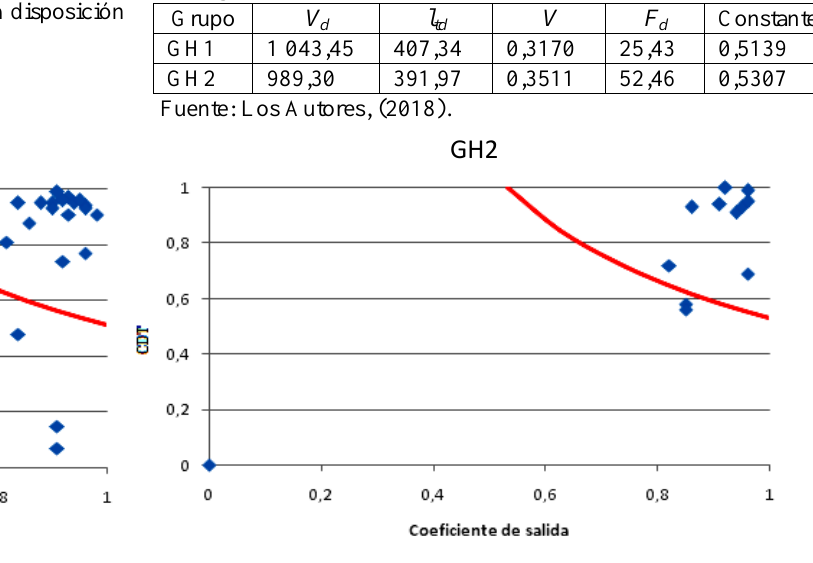
Figura 4. Comportamiento de los vehículos por GH. Fuente: Los Autores,